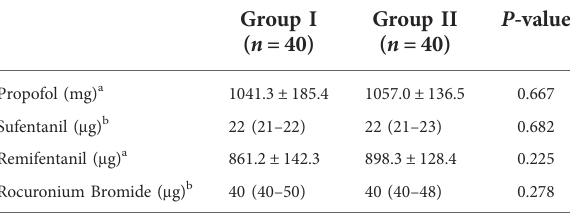
TABLE 6 Comparison of sufentanil consumption dosage in the fi rst 24 h following surgery.